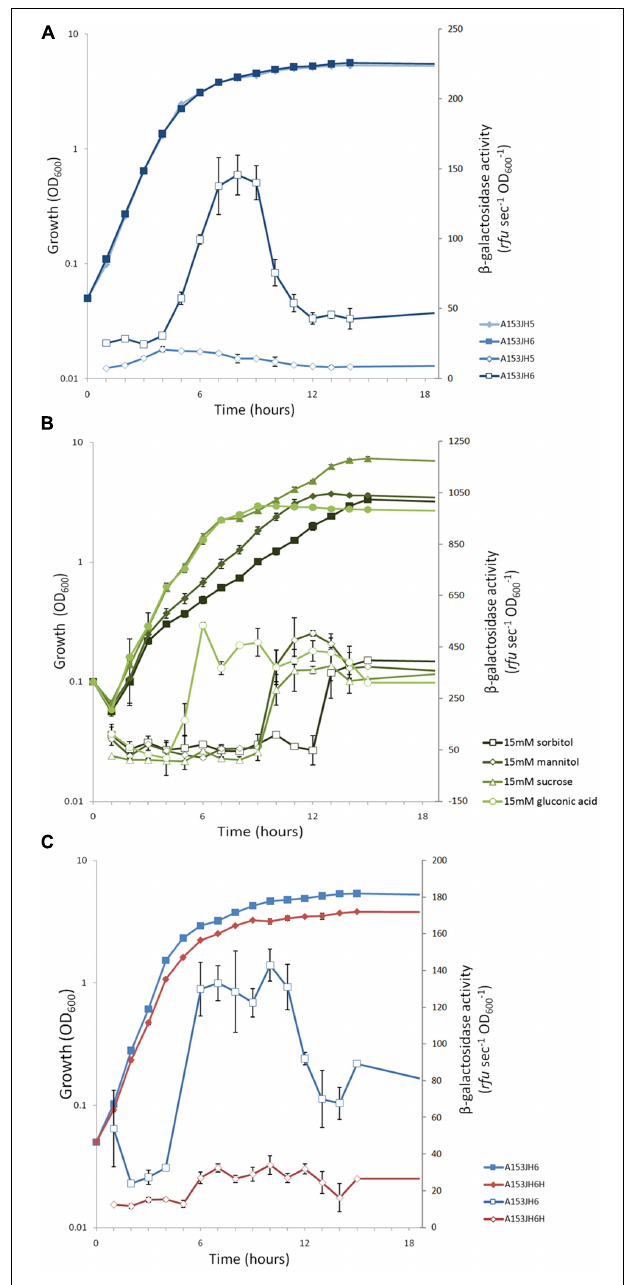
Importantly, pairwise comparisons in silico indicate that genes zmn1-4 are not present in strains of Dickeya and that the zmn5 homolog constitutes the first gene of these zmn gene